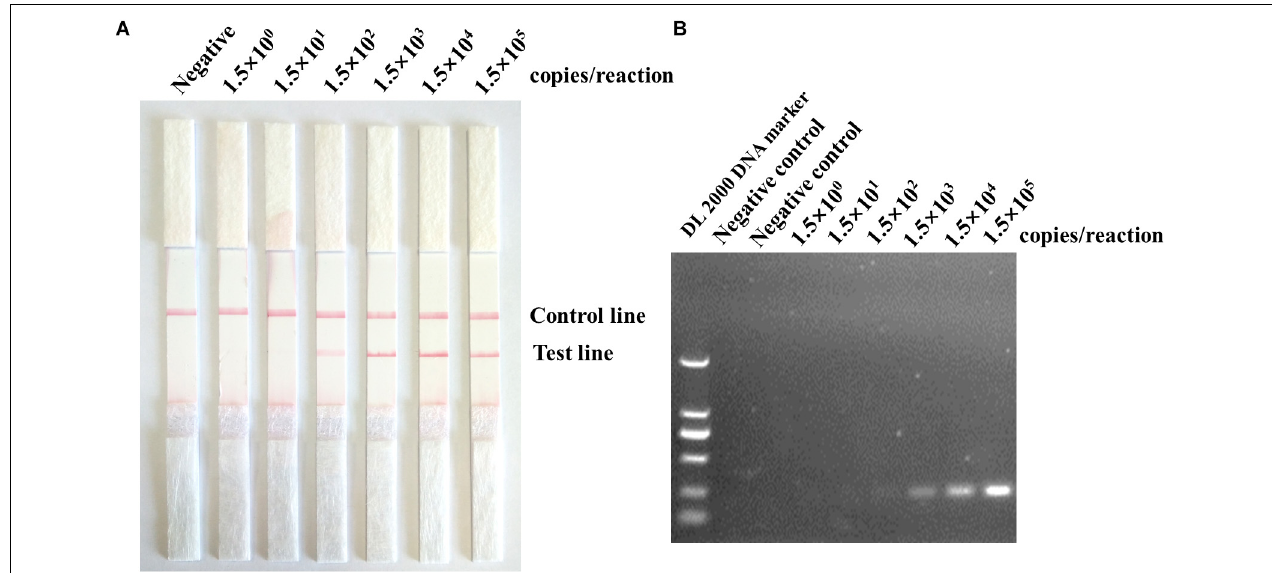
FIGURE 4 | Evaluation of the sensitivity of ASFV RPA-LFD assay. (A) In the lateral flow format (ASFV RPA-LFD), the sensitivity was 150 copies per reaction of the standard plasmid. (B) Positive ASFV RPA reaction products could be detected on the stained agarose gel (2%).